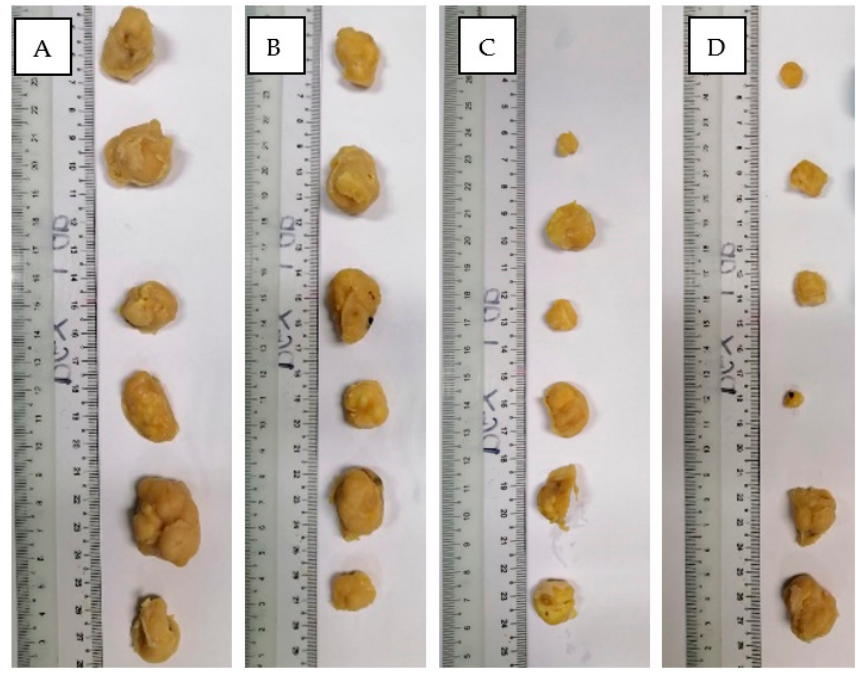
Figure 4. Harvested tumours of ( A ) control ( B ) DOX ( C ) PEG-PLGA ( D ) HA-PEG-PLGA groups.